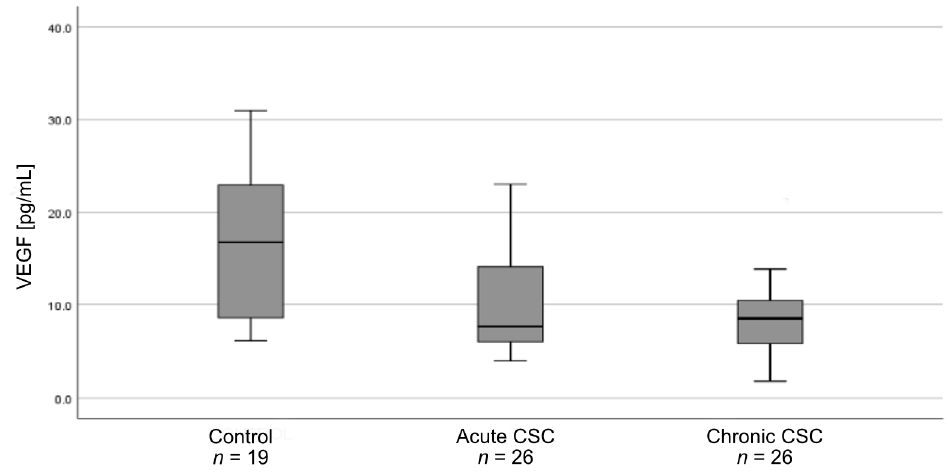
Figure 1. Box-and-whisker plot of plasma vascular endothelial growth factor (VEGF) levels in patients with acute central serous chorioretinopathy (CSC), patients with chronic CSC, and controls ( p = 0.01).